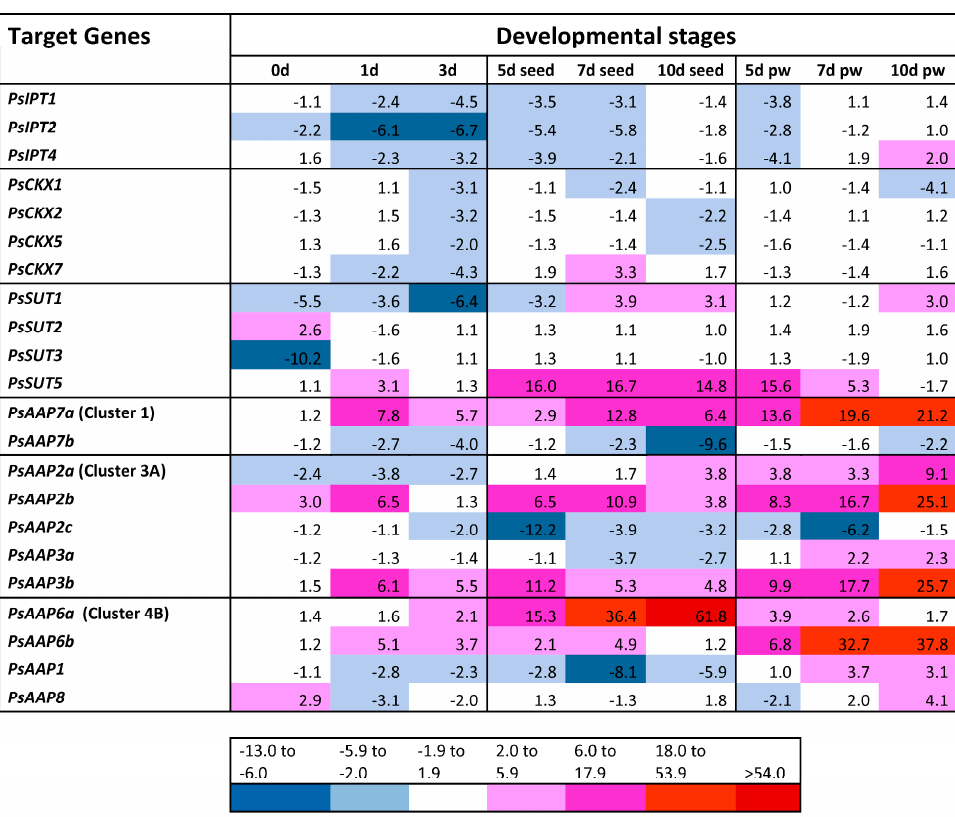
Figure 4. Relative expression of gene family members in developing fruits of P. sativum L. cv Bolero. 0 day, 1 day, and 3 day: fruit at 0, 1 and 3 days after fertilisation (DAF); 5 day, 7 day, and 10 day seed: cotyledon plus seed coat; 5 day, 7 day, 10 day pw: pod walls separated from the seed. The colour scale indicates upregulated expression ( red scale), similar ( white ) and downregulated expression ( blue scale) relative to one day before fertilisation.